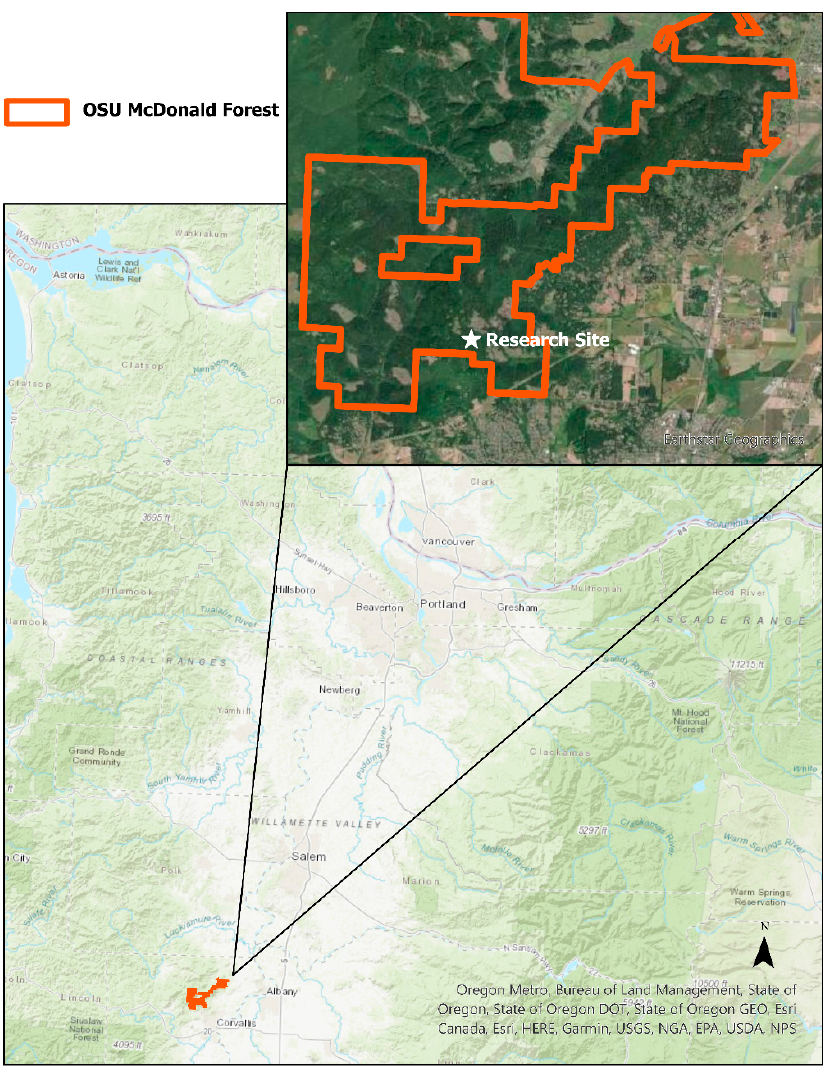
Figure 1. Vicinity map of OSU McDonald forest and research site.